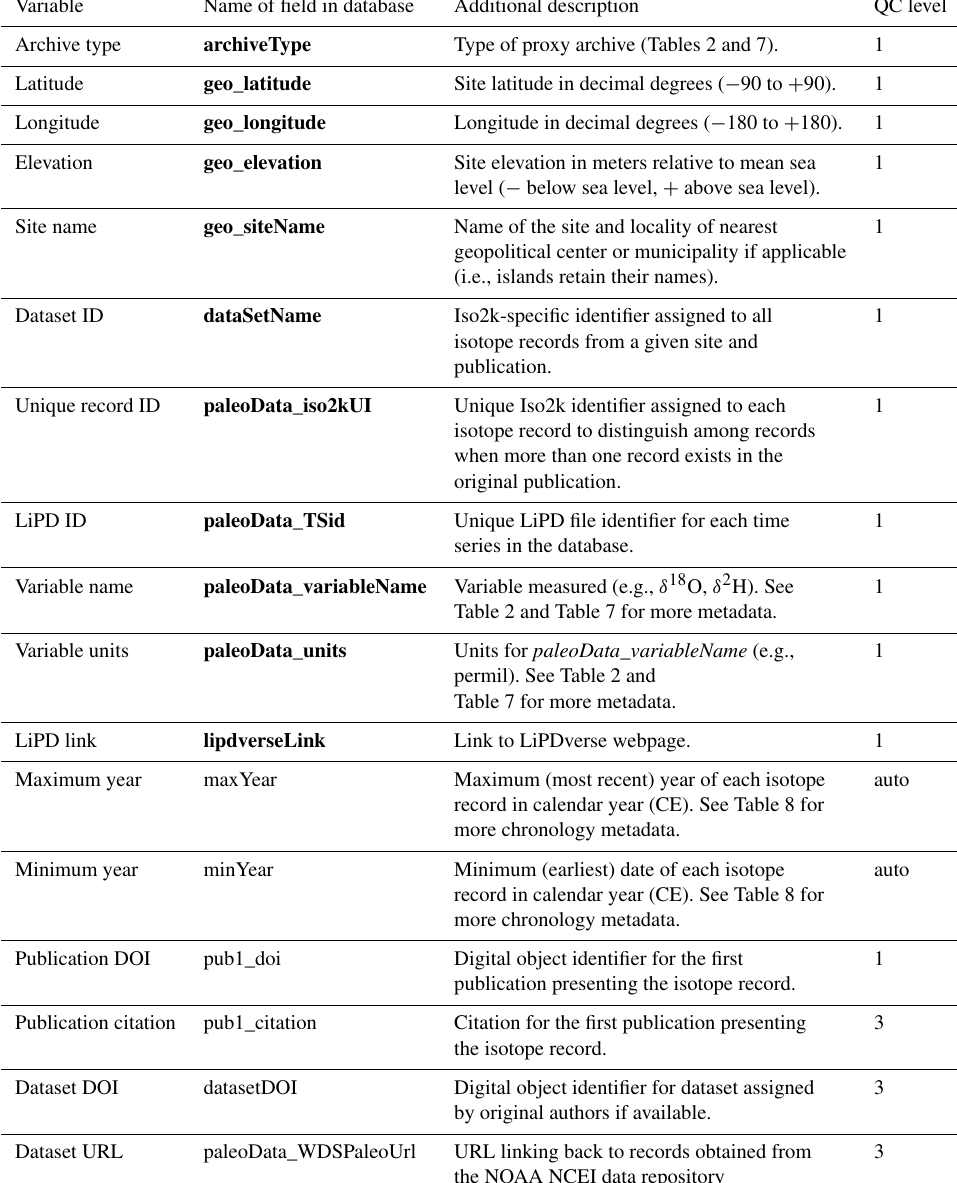
Table 1. Key entity metadata. Bold text indicates Level 1 or required fields in the database; italics are references to other metadata or variables.